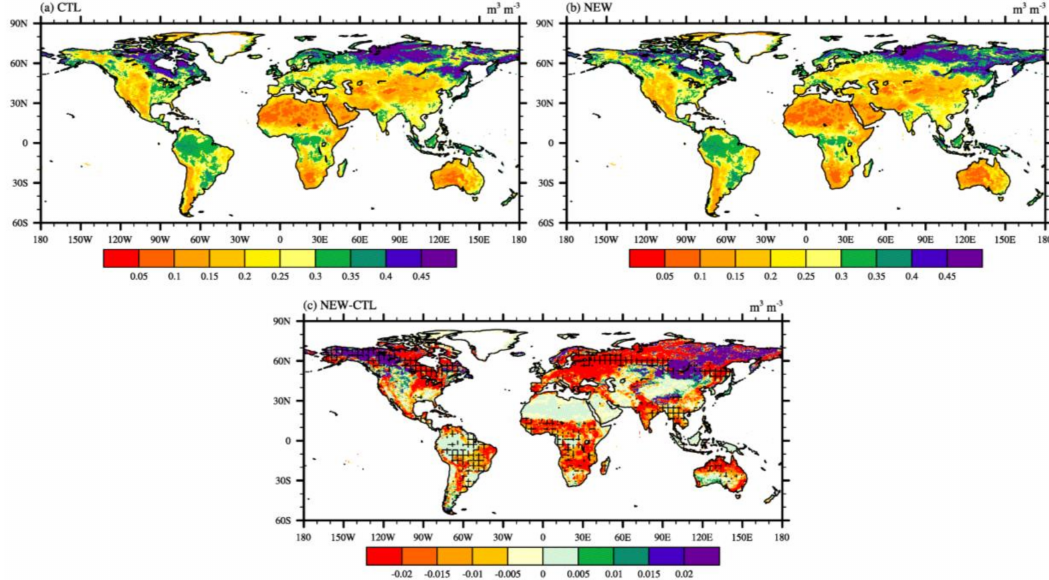
Figure 2. Annual soil moisture (SM, m 3 m − 3 ) over 1982–2005 for ( a ) the original CESM1.2.0 (CTL) run; ( b ) the CESM1.2.0_DR coupled with the dynamic rooting scheme (NEW) run; ( c ) the difference between NEW and CTL. (Grid shaded regions are significant at the 95% confidence level according to Student’s t